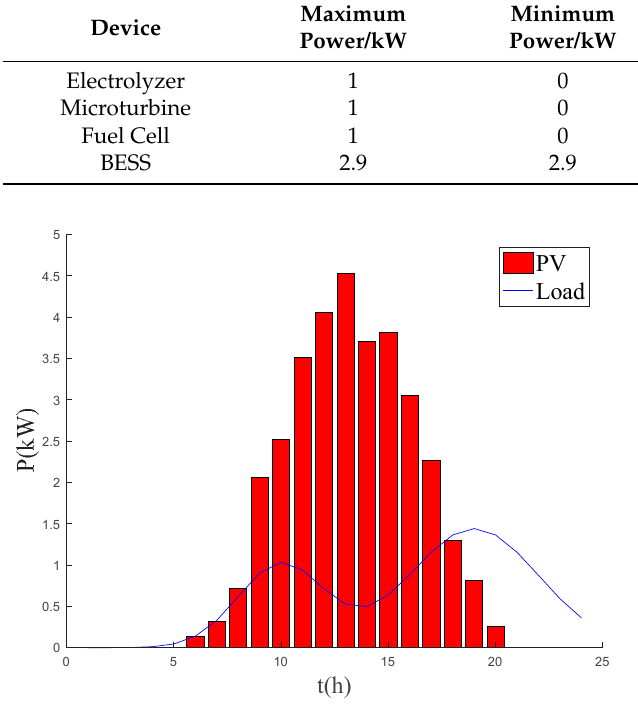
Figure 7. Typical daily PV and load forecast curves.